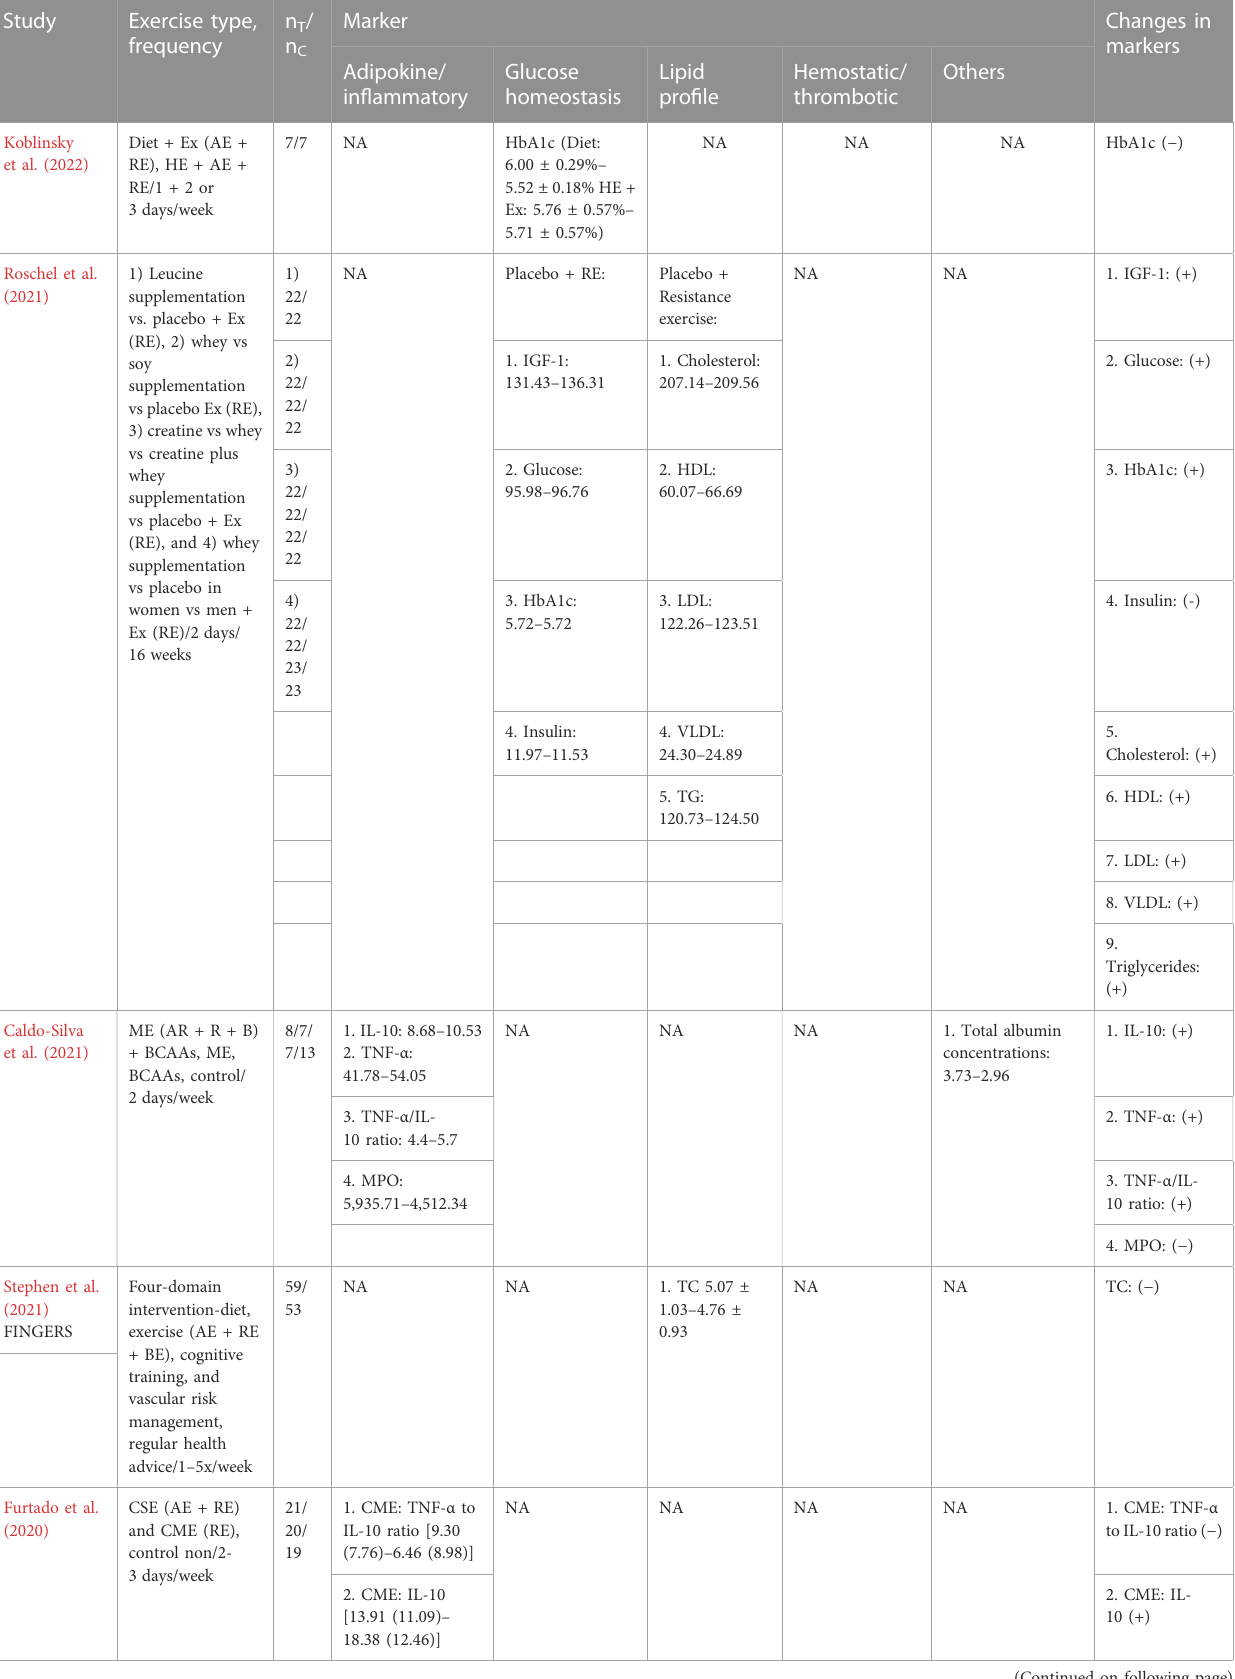
TABLE 3 Cardiovascular-health related blood parameters and response to exercise intervention.